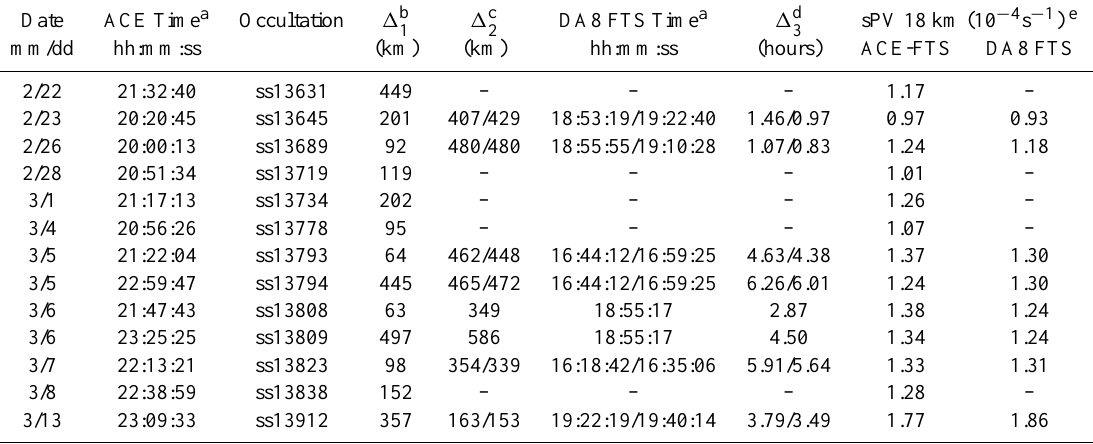
Table 9. The spatial and temporal differences between DA8 and ACE-FTS for HF during the 2006 Canadian Arctic ACE Validation Campaign.